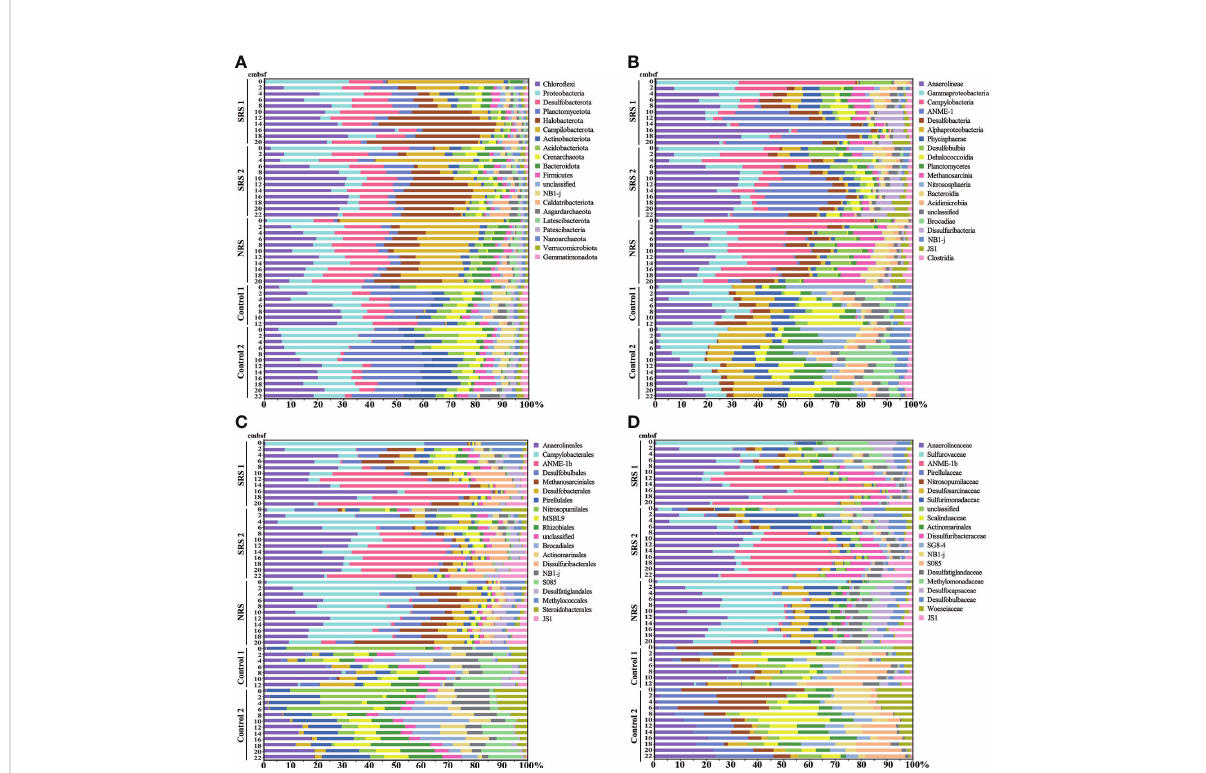
FIGURE 3 Microbial community compositions in all samples. (A) Microbial community compositions of the top 20 phyla. (B) Microbial community compositions of the top 20 classes. (C) Microbial community compositions of the top 20 orders. (D) Microbial community compositions of the top 20